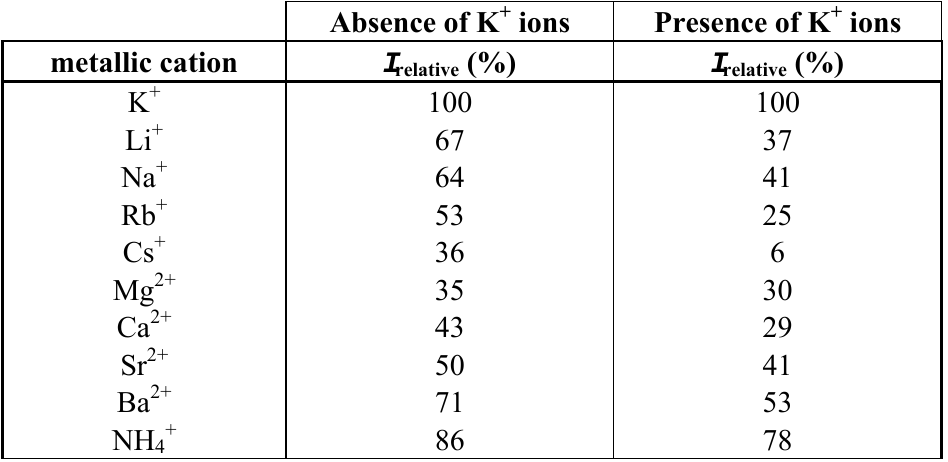
Table 1. Interference dependence of the voltammetric responses of the sensor based on hollandite-type manganese oxide in TRIS buffer solution (pH = 8) containing 4 . 8 × 10 − 4 mol L − 1 of alkaline and alkaline-earth metal ions in the absence and presence of potassium ions (4 . 7 × 10 − 4 mol L − 1